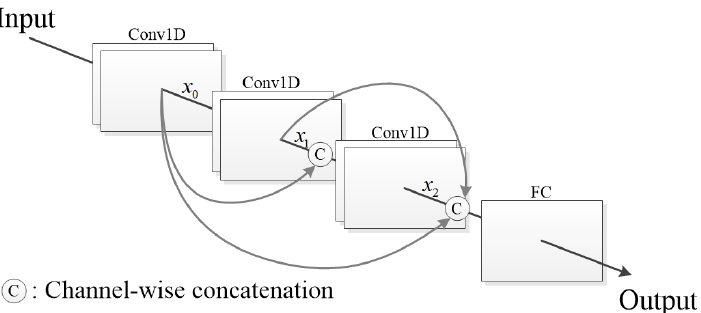
Figure 3. The Dense-Net structure. Figure 3. The Dense‑Net